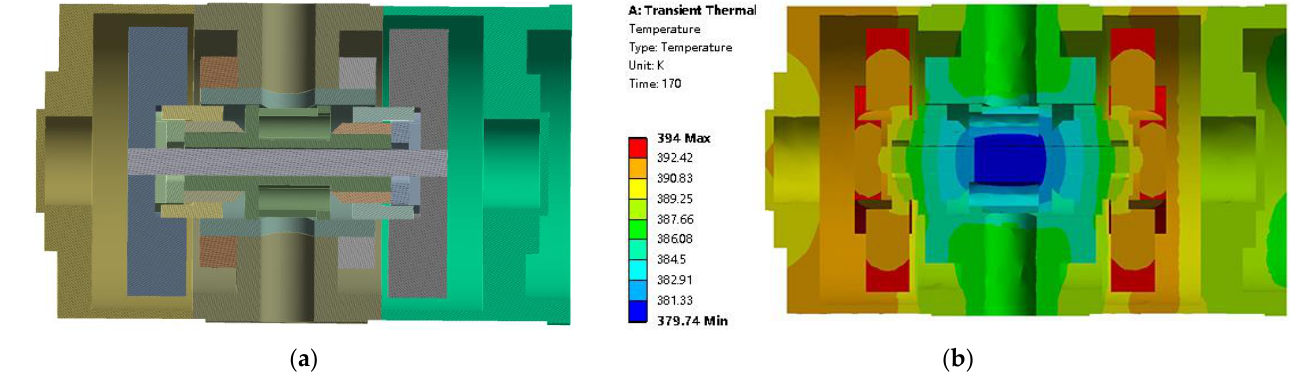
Figure 11. The heat transfer simulation of the 2D pump: ( a ) the cross-section view of the 2D pump heat transfer model; ( b ) the cross-section view of the 2D pump heat transfer simulation result at 6000 rpm.